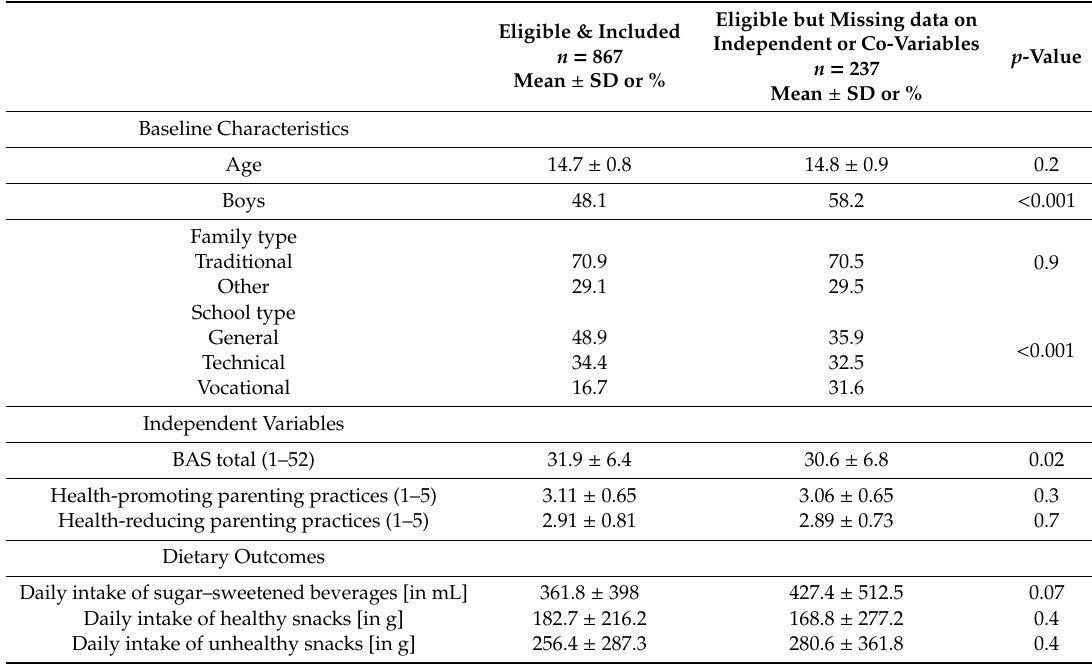
Table 1. Participant characteristics* in those eligible and included and those eligible but excluded due to missing data on at least one independent or